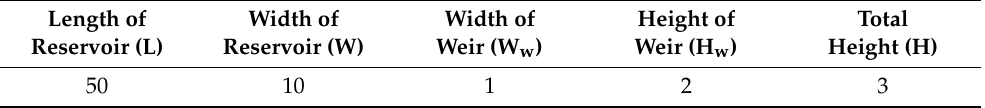
Table 2. Dimensions (m) of gabion dams and associated detention basin reservoirs (see Figure 6). Length of Width of Width of Height of Total Reservoir (L) Reservoir (W) Weir (W w ) Weir (H w ) Height (H) 50 10 1 2